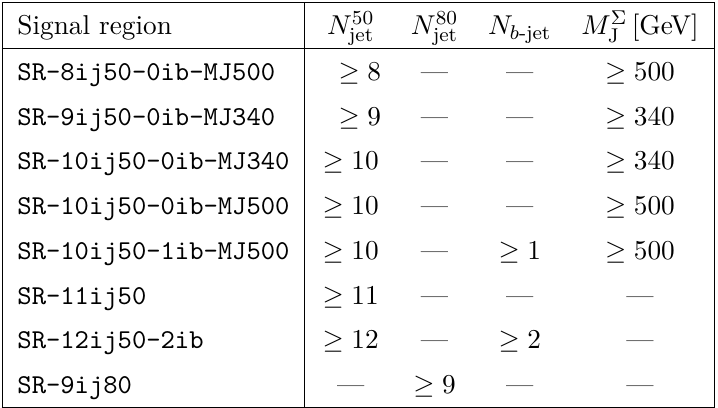
Table 7 . Summary of signal region criteria for single-bin selections in ATLAS-CONF-2020-002, reproduced in full from table 3 of [1]. A dash (-) indicates that no requirement is applied to the corresponding variable. The requirement S ( E miss ) > 5.0 is applied to all T